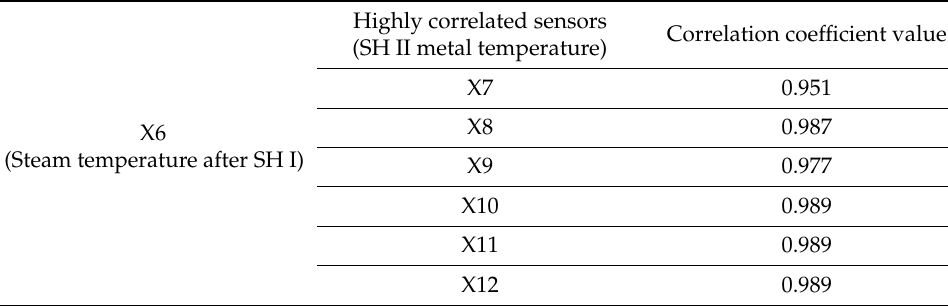
Table 3. Sensors with high correlation coefficient values.